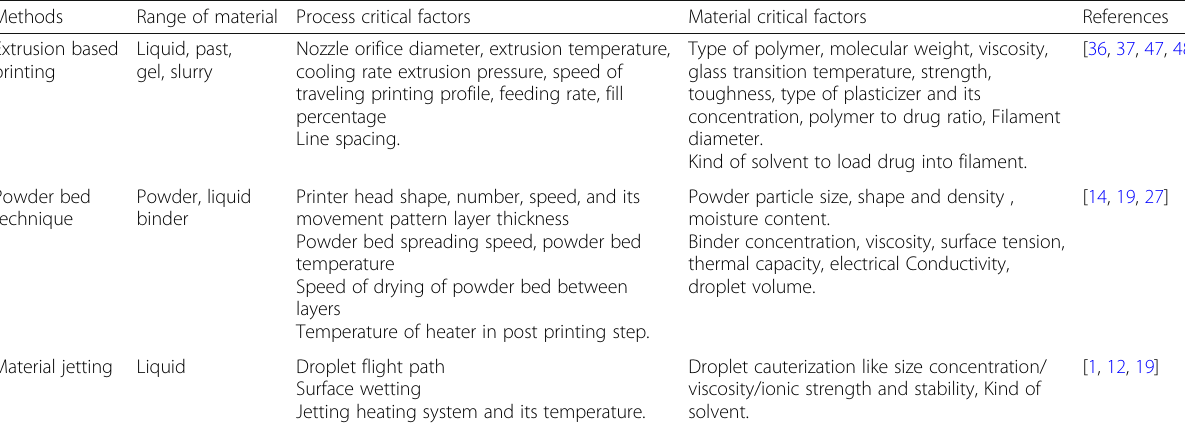
Table 1 Main critical factors affecting the manufacturing a 3D printing product